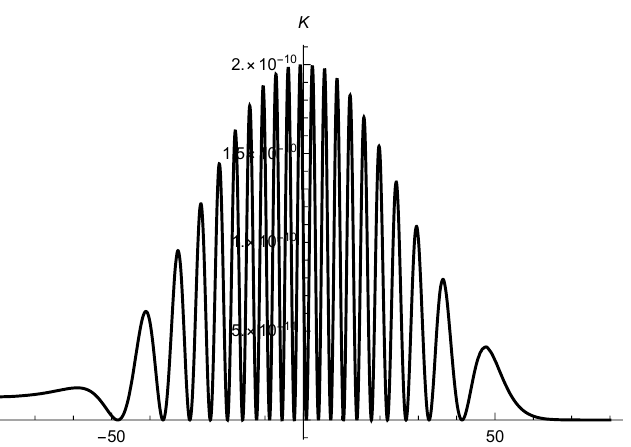
Figure 8. K ( u ) , considering H 1 , the initial conditions III and λ =